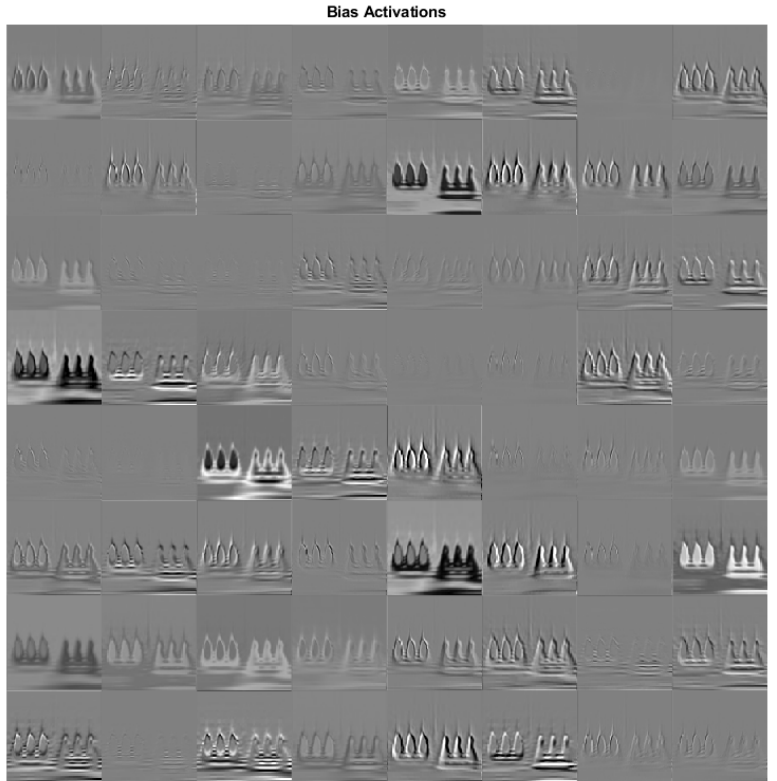
Figure 15. Sensor bias fault scenario-activated areas by convolutional